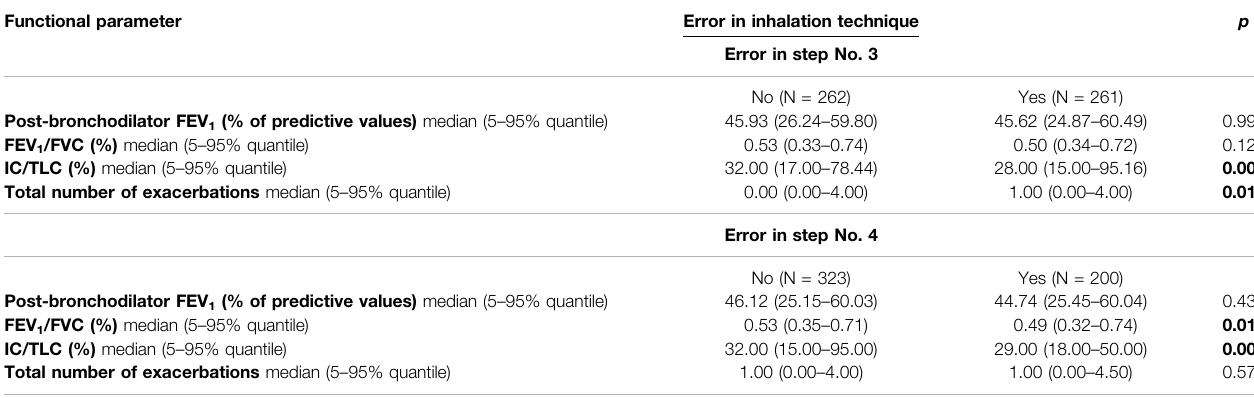
TABLE 4 | Associations between critical errors in application technique (Five Steps Assessment) and pulmonary functions and rate of exacerbations. Functional parameter